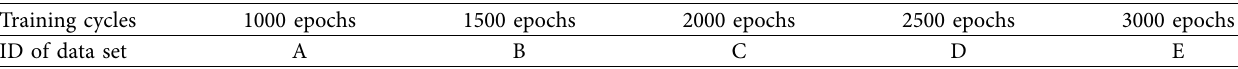
Table 6: ID of the data group.